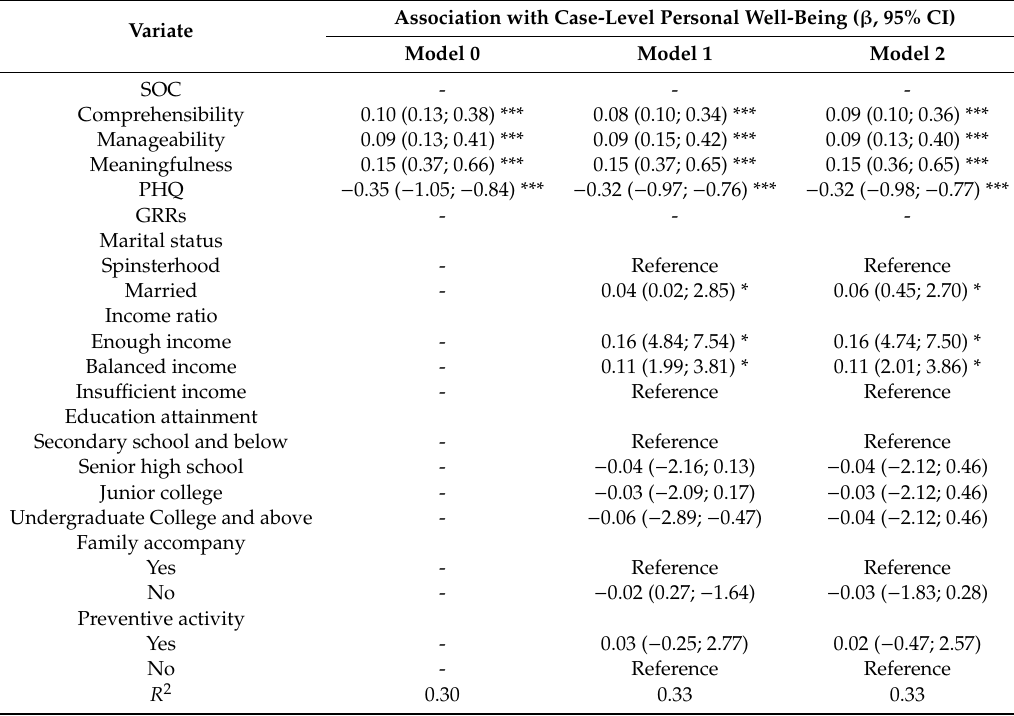
Table 3. Associations among SWB, PHQ, and generalized resistant resources (GRRs). Association with Case-Level Personal Well-Being ( β , 95% Variate